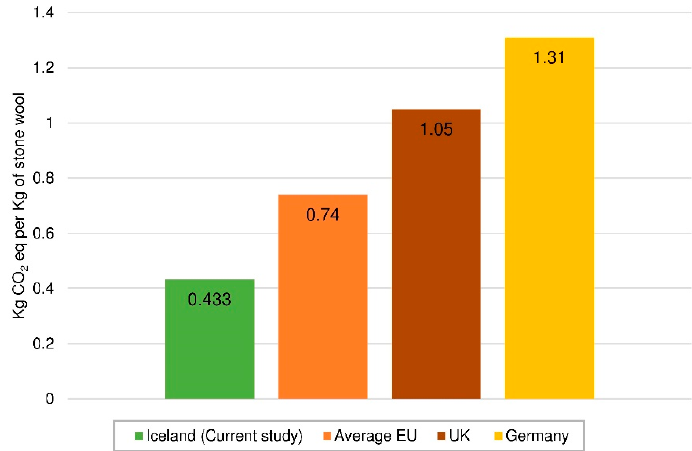
Figure 3. Comparison of GWP impact per 1 kg of stone wool.